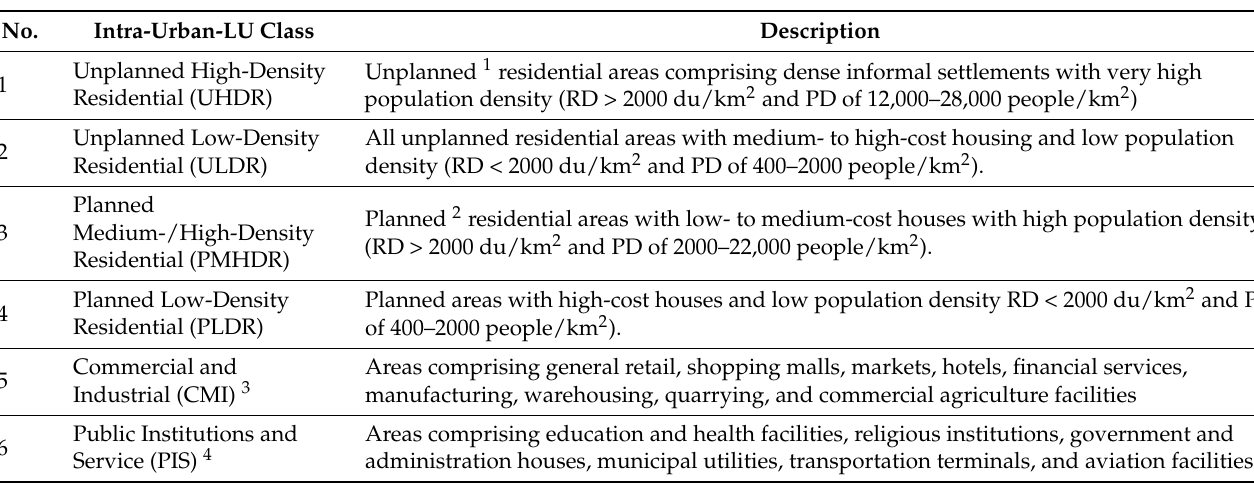
Table 1. Descriptions of the intra-urban-LU classes